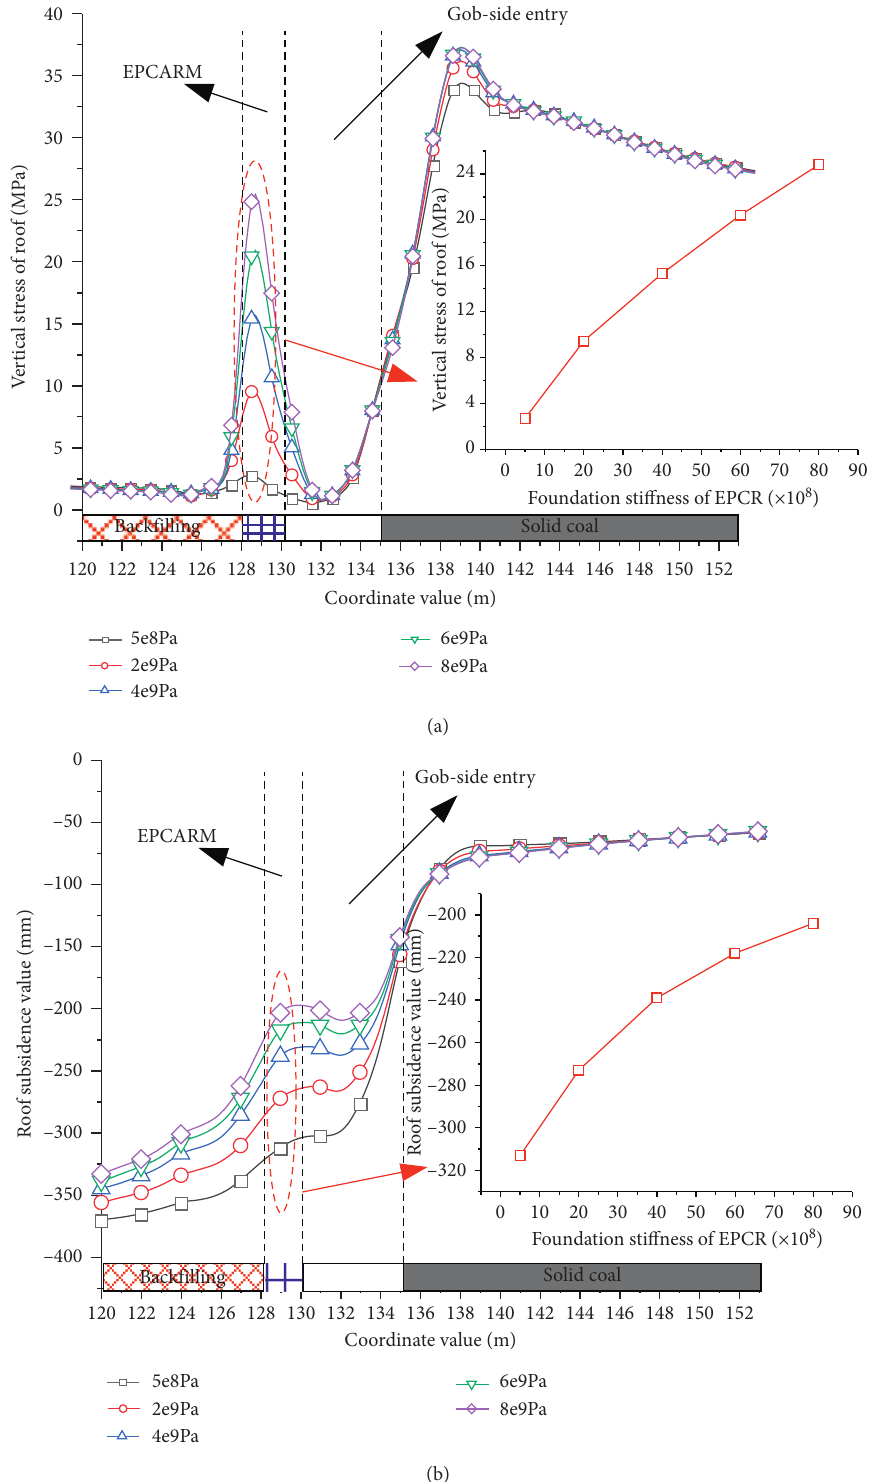
Figure 6: Roof deformation and stress variations for different foundation stiffness values of coal and rock mass. (a) Stress variation pattern. (b) Deformation variation